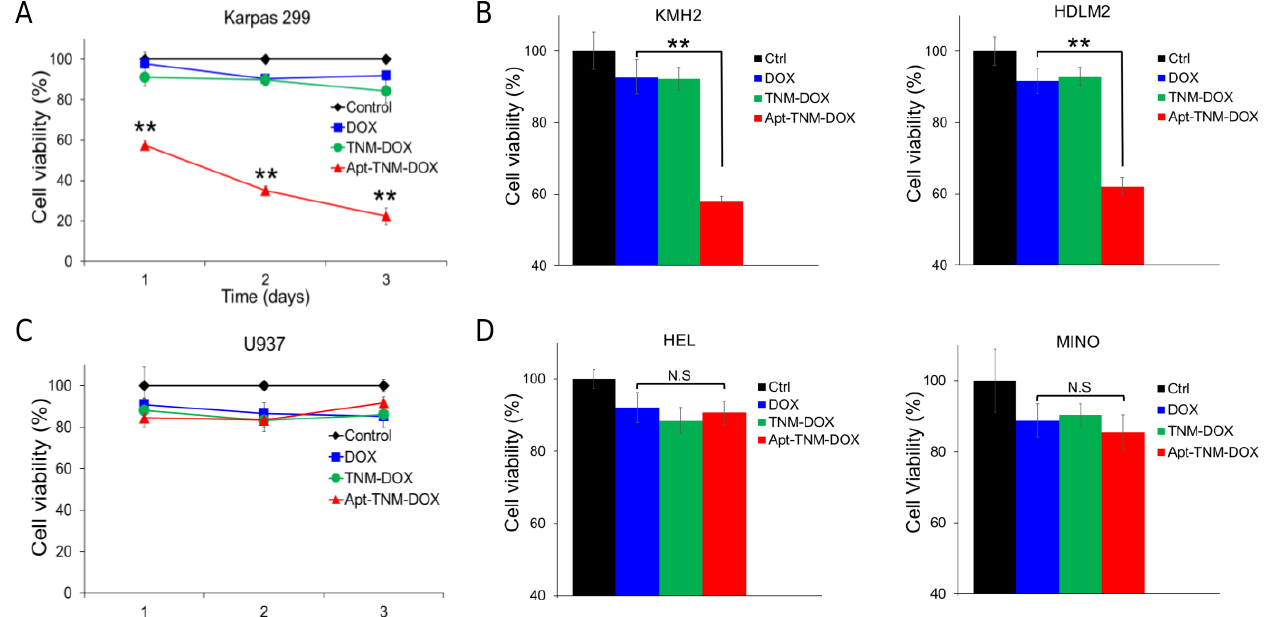
Figure 7. Apt–TNM-DOX specifically targets lymphoma cells and inhibits cell growth. ( A ) Apt–TNM-DOX treatment inhibited the growth of Karpas 299 lymphoma cells. ( B ) Three days after Apt–TNM-DOX treatment, a similar inhibitory effect was observed in KMH2 and HDLM2 lymphoma cells. ( C ) Apt–TNM-DOX treatment had no effect on off-target U937 control cells. ( D ) No inhibitory effect on additional off-target control cells, HEL and Mino cells was observed three days after Apt–TNM-DOX treatment. ** p < 0.01. N.S. indicates that the difference was not significant.